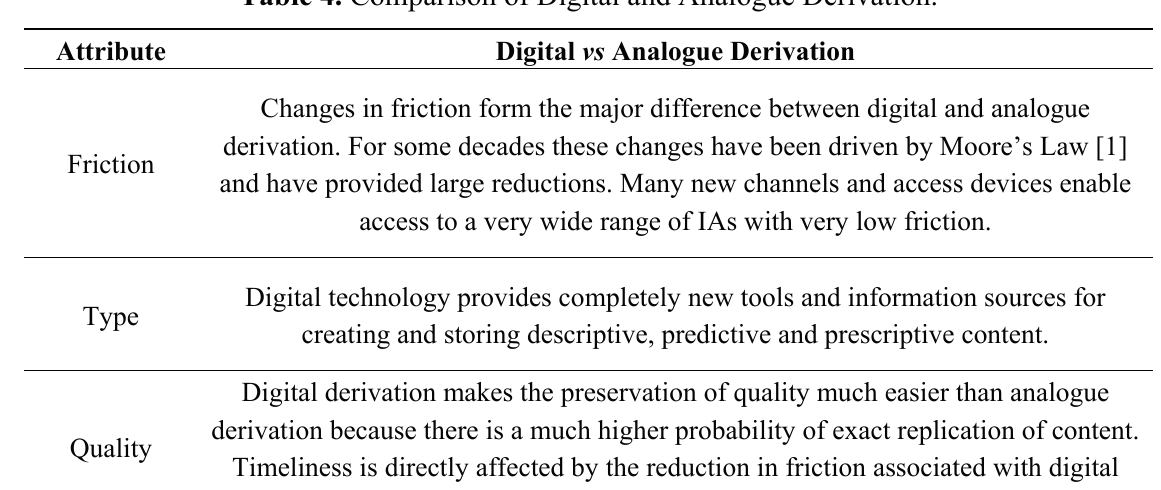
Table 4. Comparison of Digital and Analogue